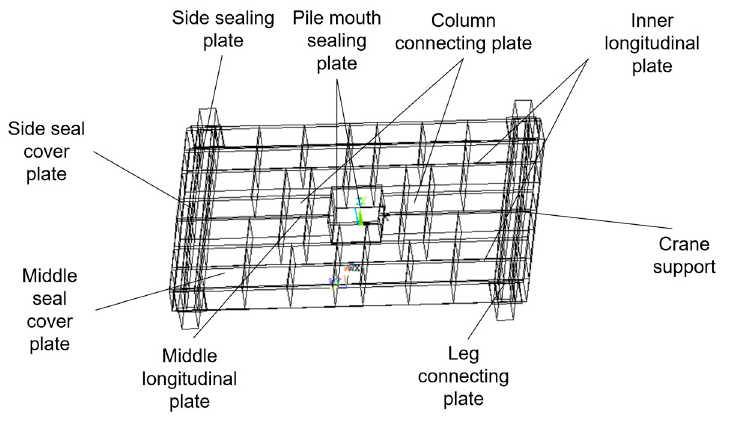
Figure 4. Large structure component drawing.